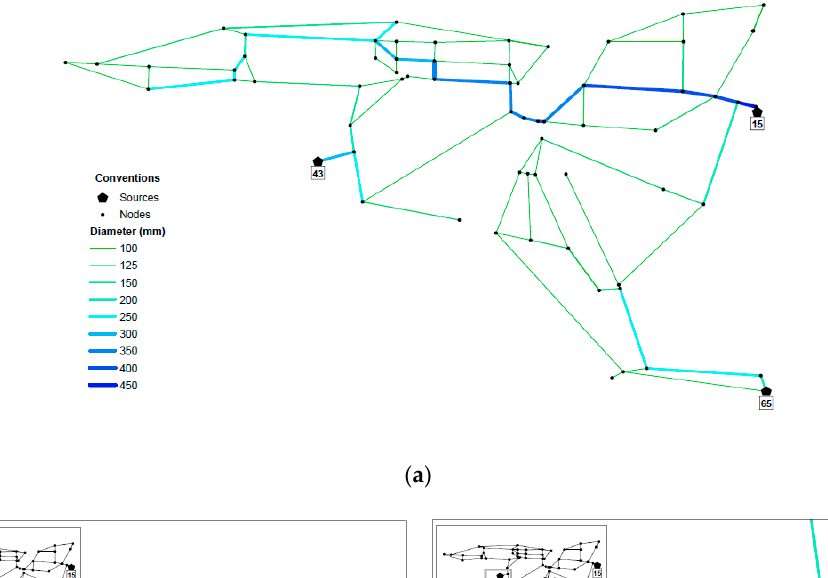
Table 8. Reported costs and number of iterations for the Pescara WDS.